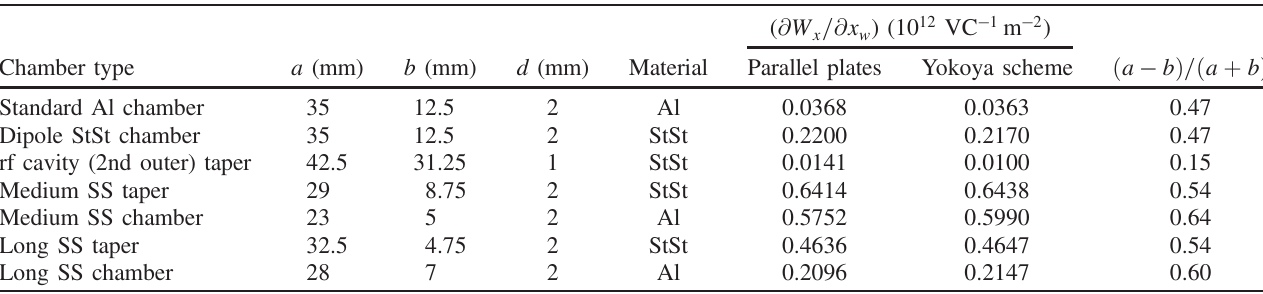
TABLE I. The exact values ∂ W x = ∂ x w (evaluated at z ¼ 1 m) obtained with the scheme [1] and those via the analytical formula for parallel plates [2] for SOLEIL chambers. a : horizontal half aperture; b : vertical half aperture; d : chamber thickness at x ¼ 0 ; Al: aluminum ( ρ R ¼ 2 . 8 × 10 − 8 Ω m); StSt: stainless steel ( ρ R ¼ 100 × 10 − 8 Ω